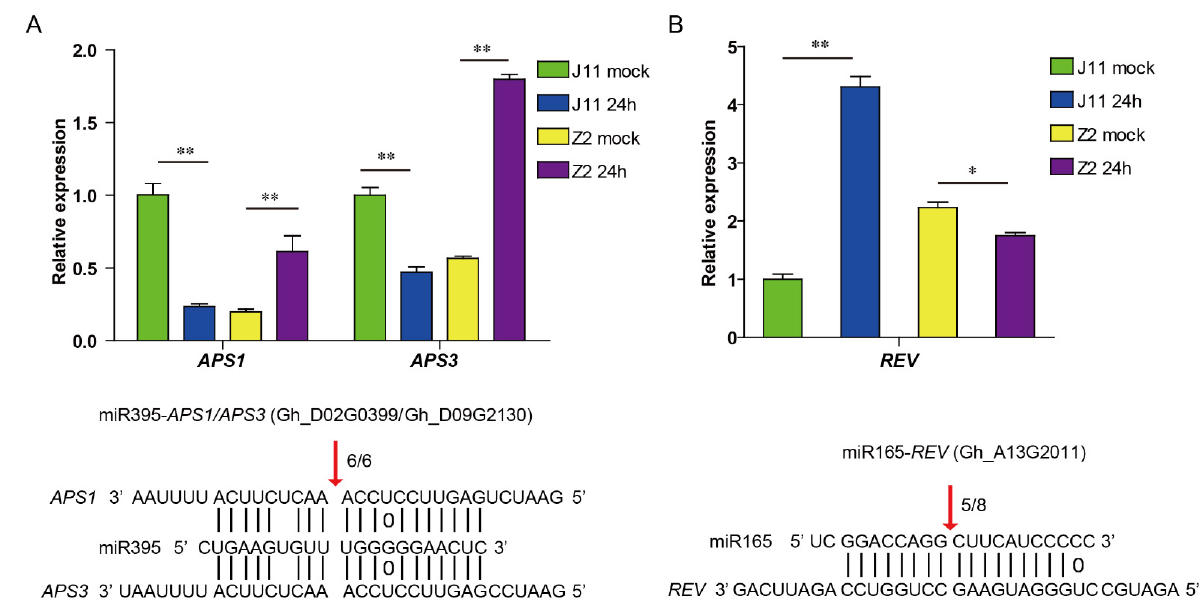
Figure 6. GhmiR395- APS1/3 and GhmiR165- REV module were validated by qRT-PCR and 5 ′ RLM- RACE. ( A ). qRT-PCR was performed to determine the expression levels of GhAPS1/APS3/REV. GhUBQ7 was used as an internal control and data are means ± SD from three biological replicates. * and ** indicates a significant difference at p < 0.05 and p < 0.01 compared with mock using a two-tailed Student’s t -test. ( B ). The cleavage sites of GhAPS1/APS3/REV mRNA were determined by the 5 (cid:48) RLM-RACE method. Arrow indicates the 5 (cid:48) terminus of miRNA-guided cleavage products, as identified by 5 (cid:48) -RACE, with the frequency of clones (6/6 and 5/8) are